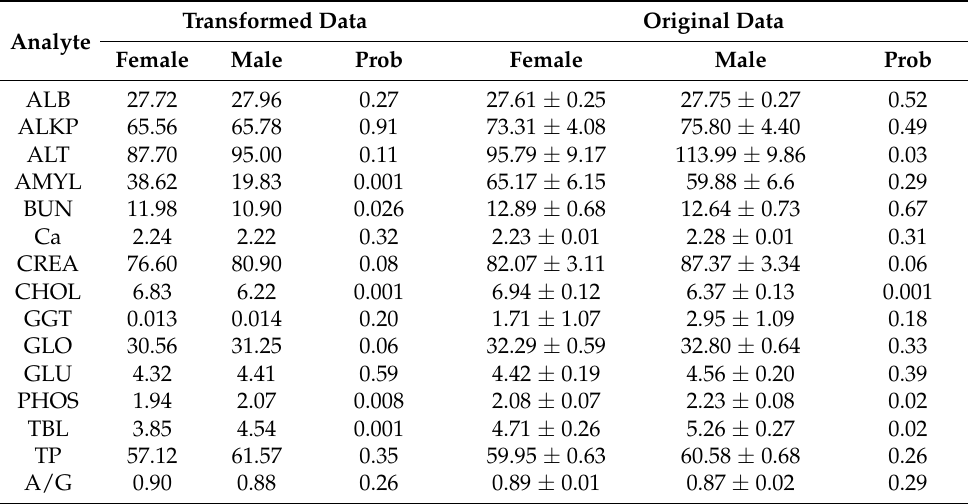
Table 5. The back-transformed values of Box–Cox transformed data and least-squares means ± standard errors of the original serum analytes of males and females, and probabilities of differences between sexes (Prob).